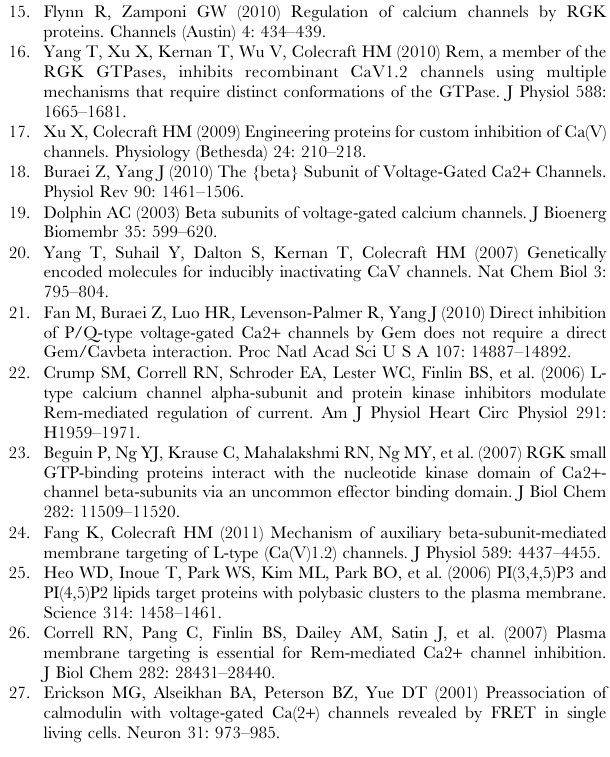
Figure S5 Mapping the Rem binding site in a 1C N- terminus. (A) Schematic of a 1C NT peptide fragments used to map Rem binding site. (B) Co-localization pattern of specific YFP- tagged a 1C N-terminus fragments with CFP-Rem at the plasma membrane suggests Rem binds the distal end of a 1C N-terminus. Scale bar, 5 m m. (C) Relative membrane to cytosol fluorescence intensity ratios for YFP-tagged a 1C NT fragments co-expressed